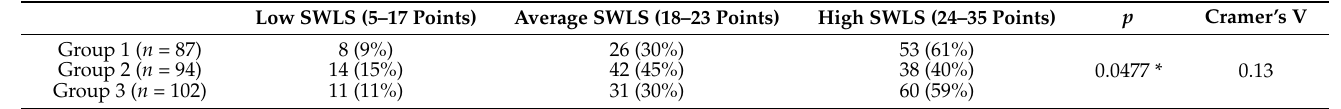
Table 4. Prevalence of low and high satisfaction with life in the three groups (the χ 2 test). Low SWLS (5–17